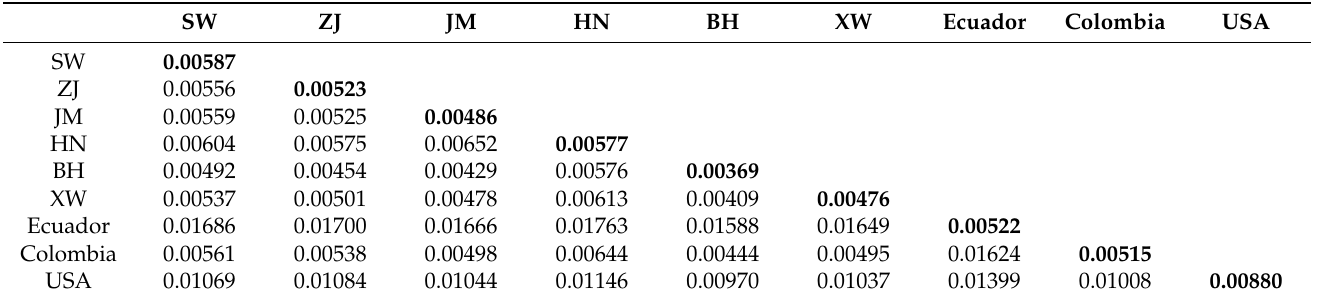
Table 5. Genetic distances between populations (below the diagonal) and genetic distances within six Chinese populations (in bold values) and three western hemisphere populations (United States, Ecuador, and Colombia) of Mytella strigata according to variation of the partial F-COI gene. JM, Jimei; SW, Shanwei; XW, Xuwen; BH, Beihai; ZJ, Zhanjiang; HN, Hainan. Populations from Ecuador and Colombia are natural populations, and the United States population is an invasive